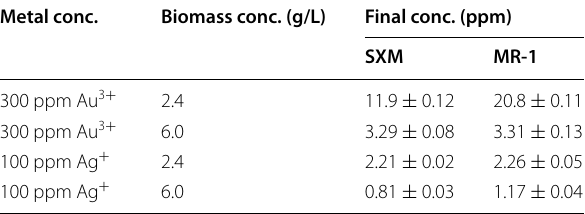
Table 4 ICP-OES analysis of residual ion